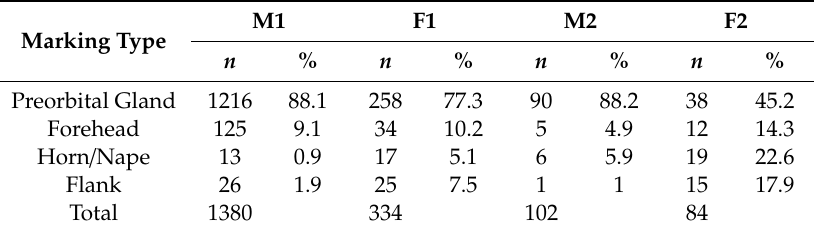
Table 1. Occurrence of different mark types. M1–F1: pair of Dusit Zoo, M2–F2: pair of Khao Kheow. n = number of observations, % = percentage of the total.